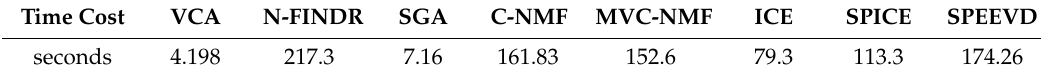
Table 10. The average running time of all methods on Lunar